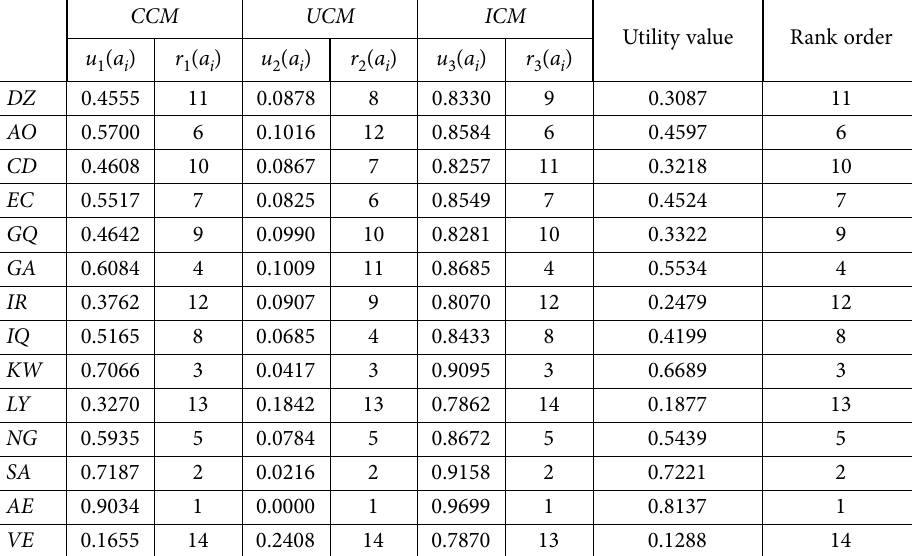
Table 7. The results obtained by